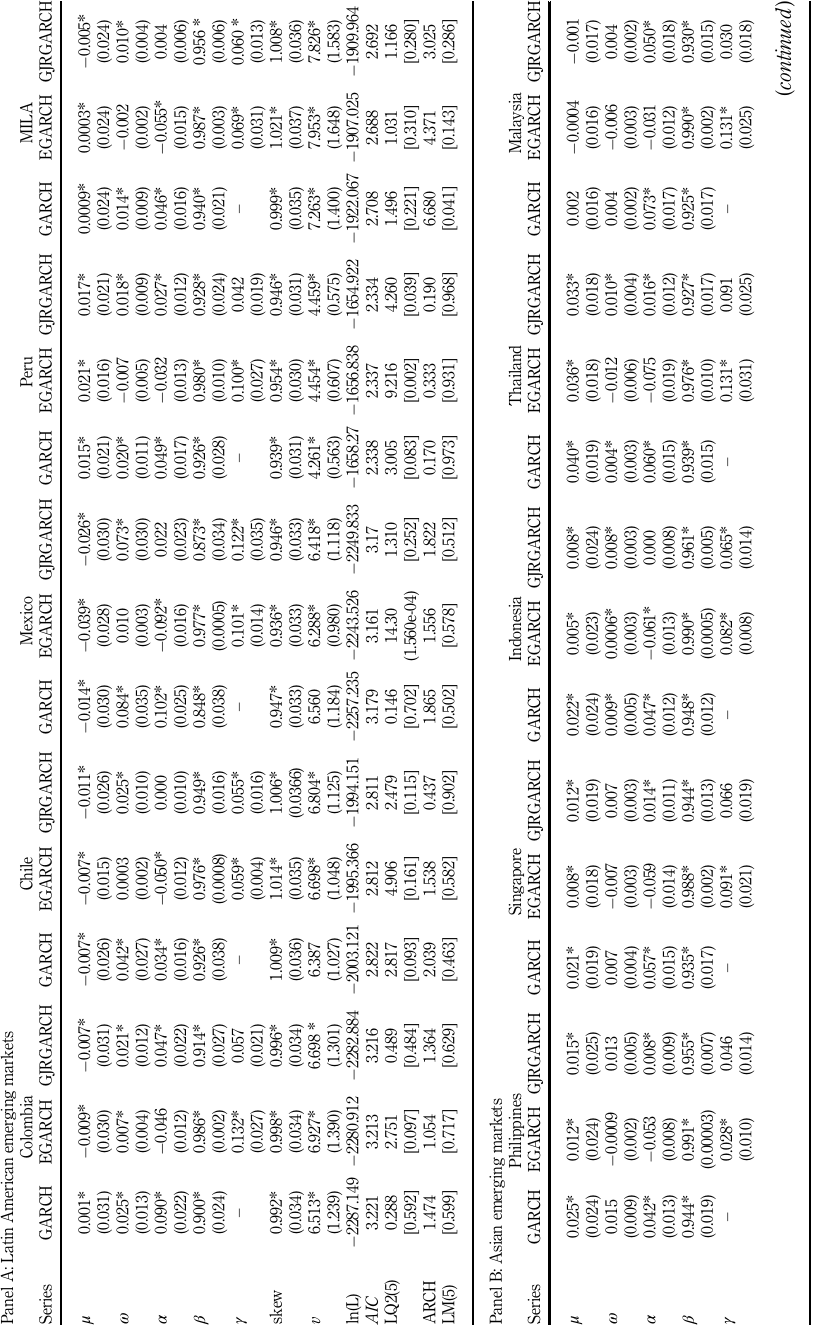
Table 5. Estimation results for different volatility models with t